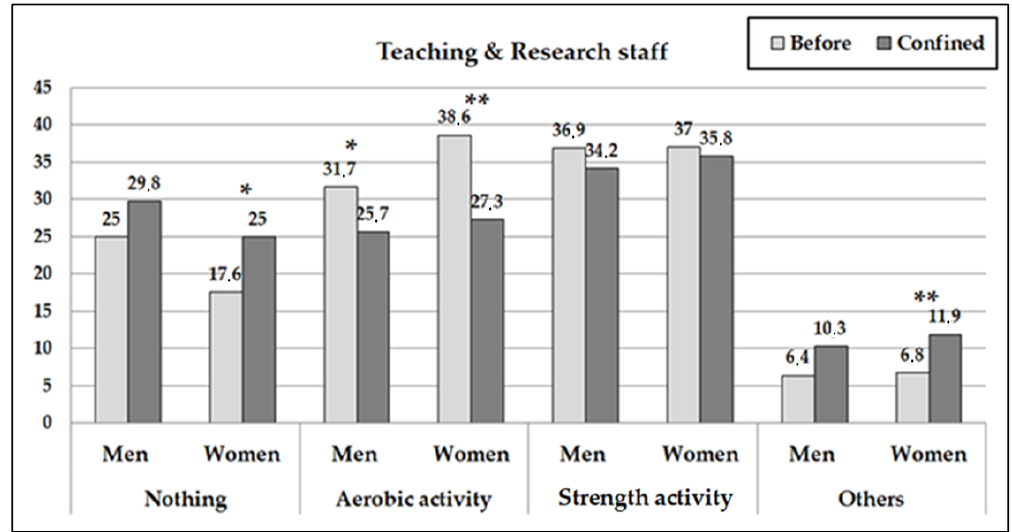
Figure 4. Percentages of teaching and research workers who carried out physical activity according to the type of physical activity carried out before and after the confinement. (The asterisks indicate the significant differences before and during confinement by sex subgroup: * p < 0.05; ** p < 0.01)